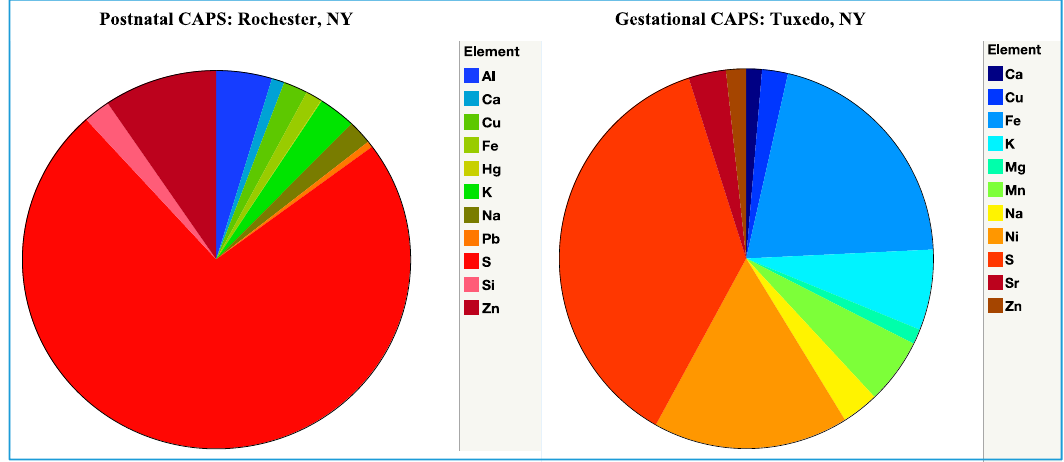
Figure 2. Tree-maps of trace elements from elements from ambient UFP exposures analyzed via XRF analysis of filters from postnatal ( left ; Rochester, NY) or gestational exposures ( right ; Tuxedo NY). Modified from Cory-Slechta et al., 2019 [92].